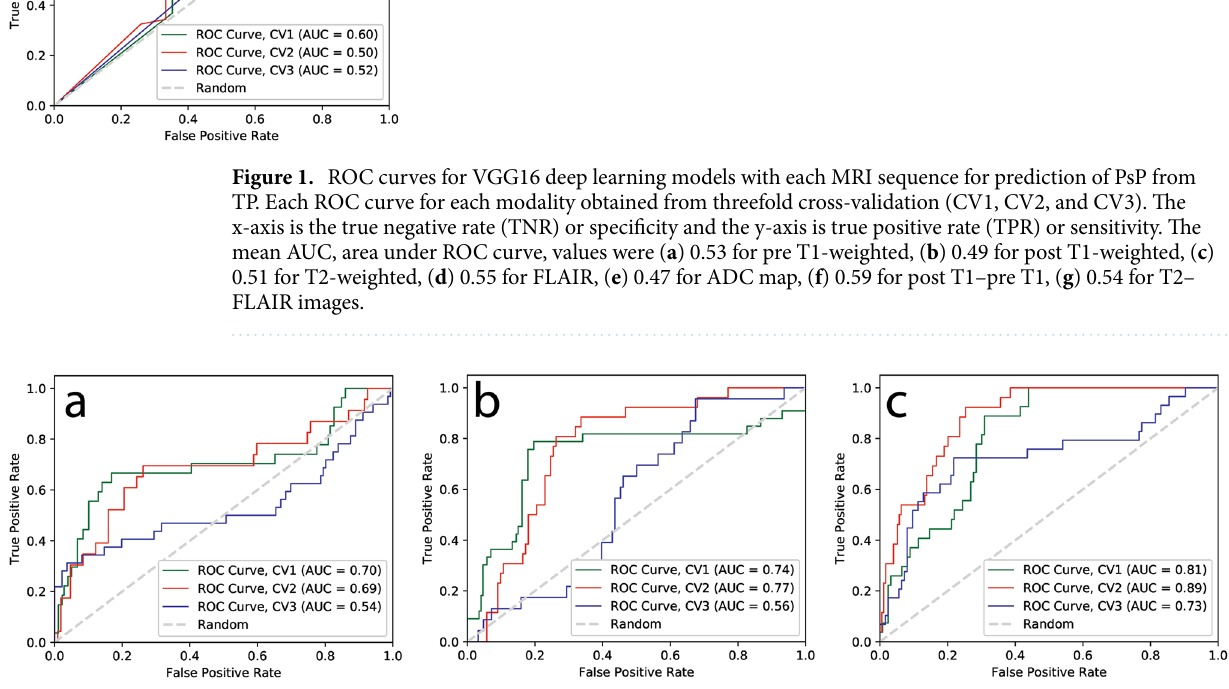
Figure 2. ROC curves for CNN-LSTM deep learning models with a different set of sequences for prediction of PsP from TP. Each ROC curve for each modality obtained from threefold cross-validation (CV1, CV2, and CV3). The x-axis is the true negative rate (TNR) or specificity and the y-axis is true positive rate (TPR) or sensitivity. The mean AUC, area under ROC curve, values were ( a ) 0.64 for a set of 3 modalities, ( b ) 0.69 for a set of 5 modalities, and ( c ) 0.81 for a set of 7